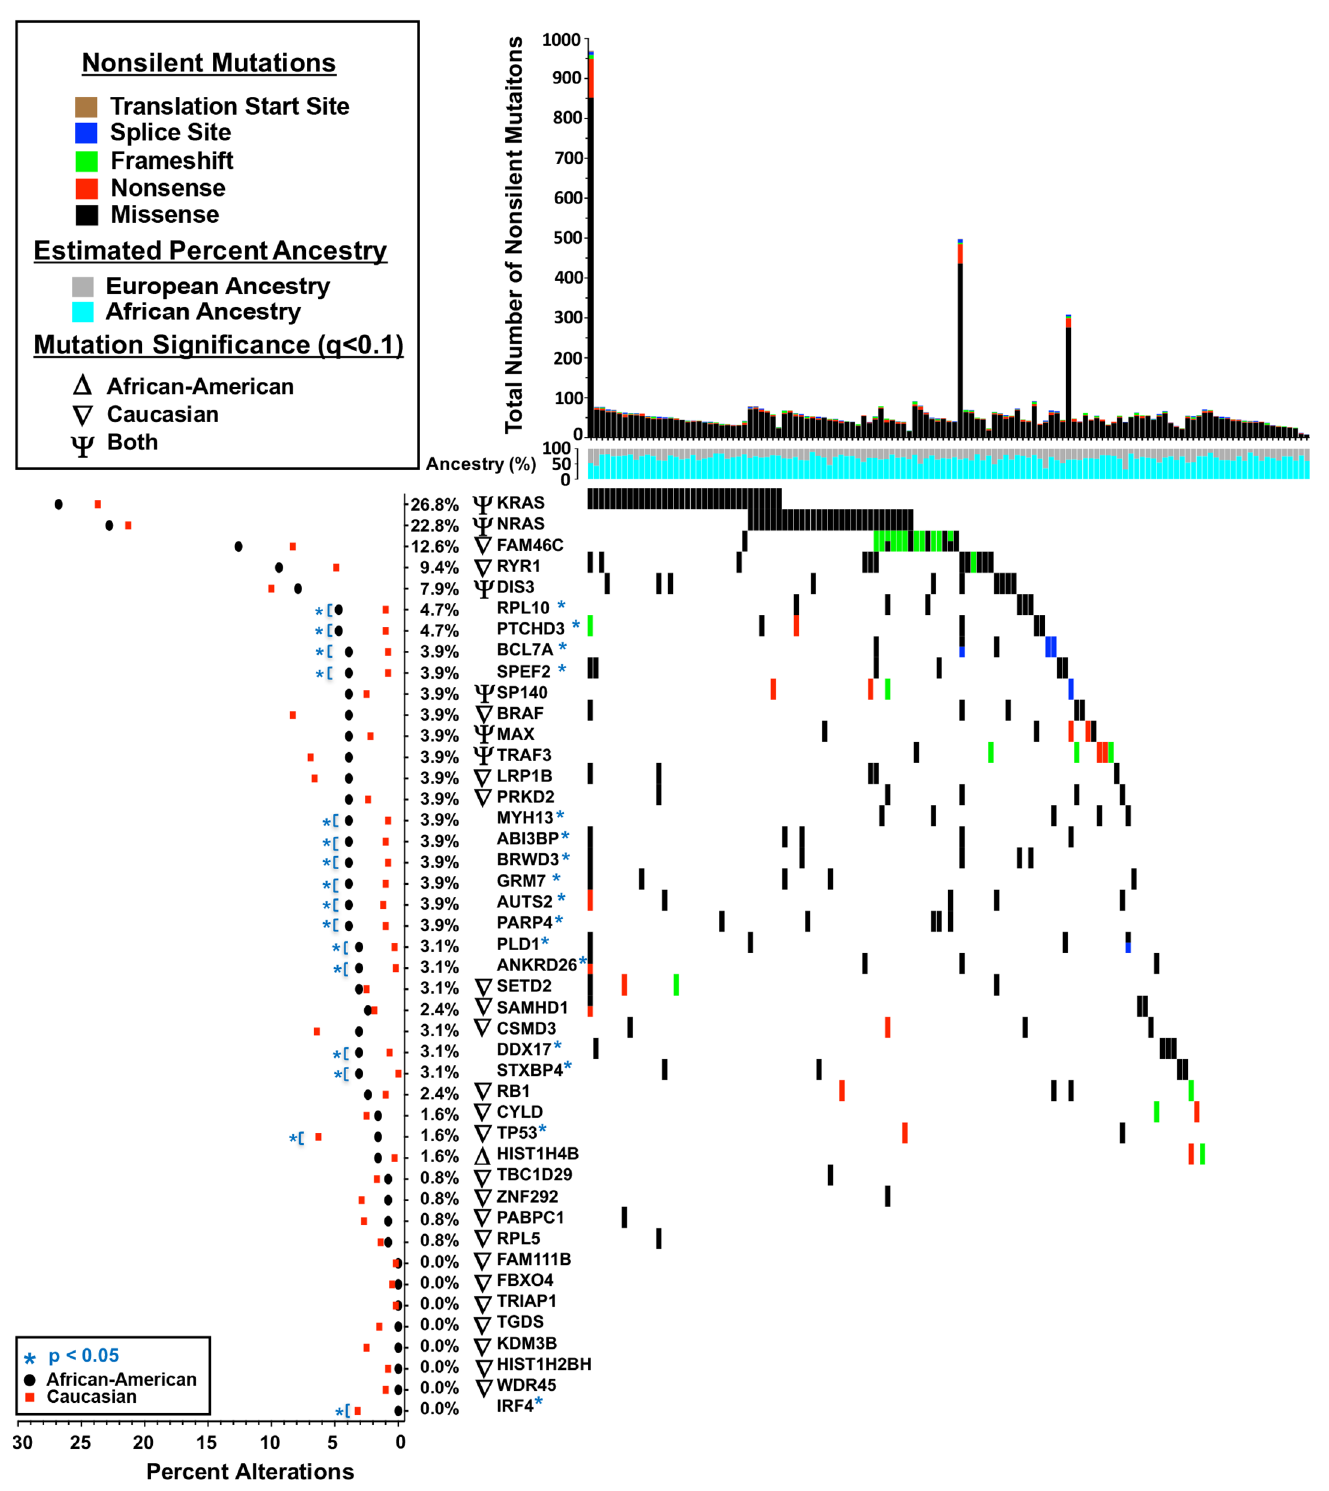
Fig 3. Frequencies of recurrently mutated genes in human MM. (Top) The total numberof acquirednonsilent somatic mutations across 127 tumors from African Americanpatients. Percent ancestry track is indicating the distributionof geneticancestry amongeach sample. (Center) mutations across recurrentgenes amongAfrican Americanpatients coloredby mutation type. (Left) Mutation significance analysiswas performed using MutSigCV (Methods) on two cohorts African American(n = 127) and Caucasian (n = 591) independently. For each analysis,significancewas determinedusing